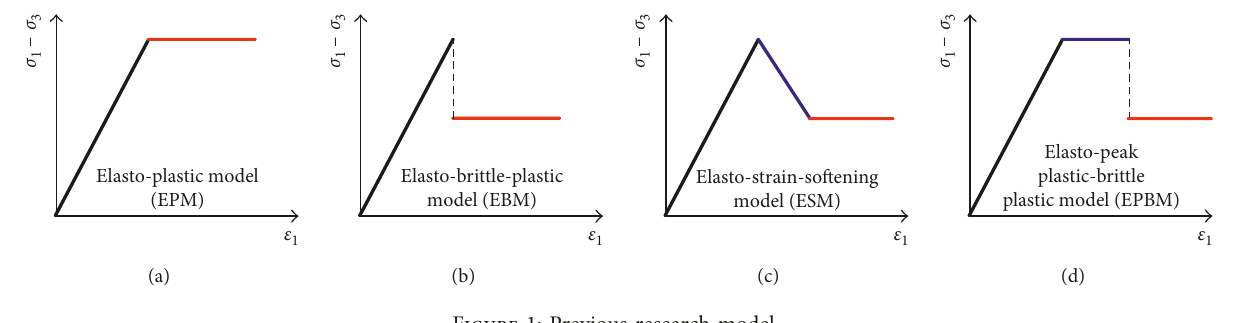
Figure 1: Previous research